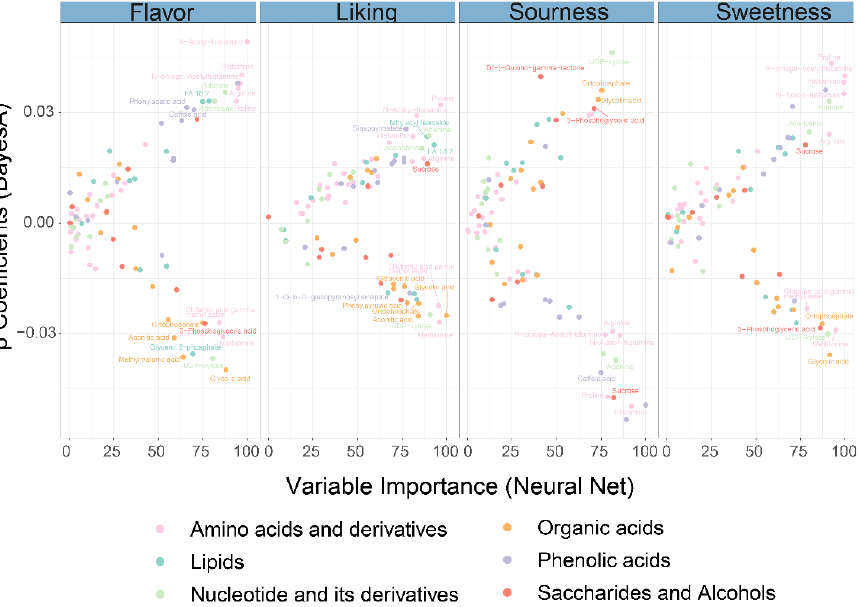
Figure 5. Role of metabolites on sensory panel. β coefficient from the Bayes A ( X -axis), variable importance from the Neural Net ( Y -axis).